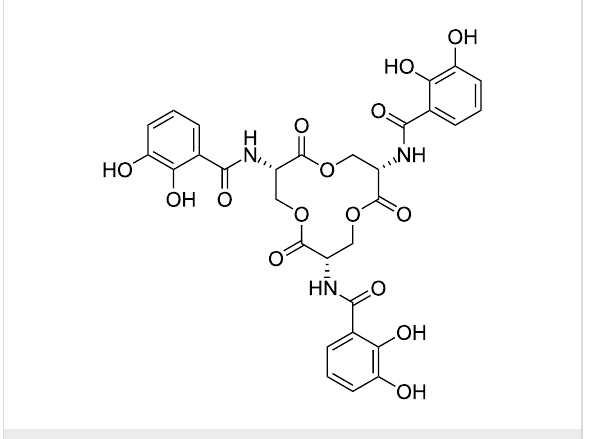
Figure 1: Structural formula of the siderophore